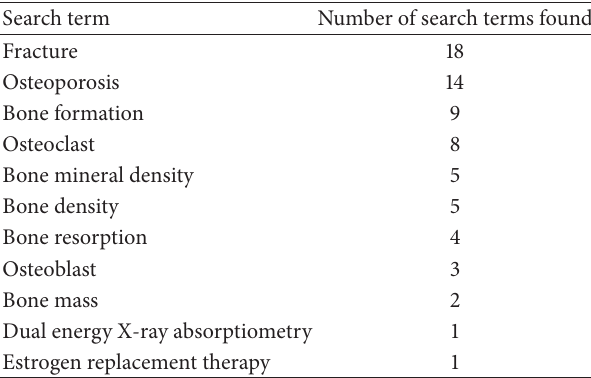
Table 3: Most frequent search terms ( 𝑛 = 11 ).